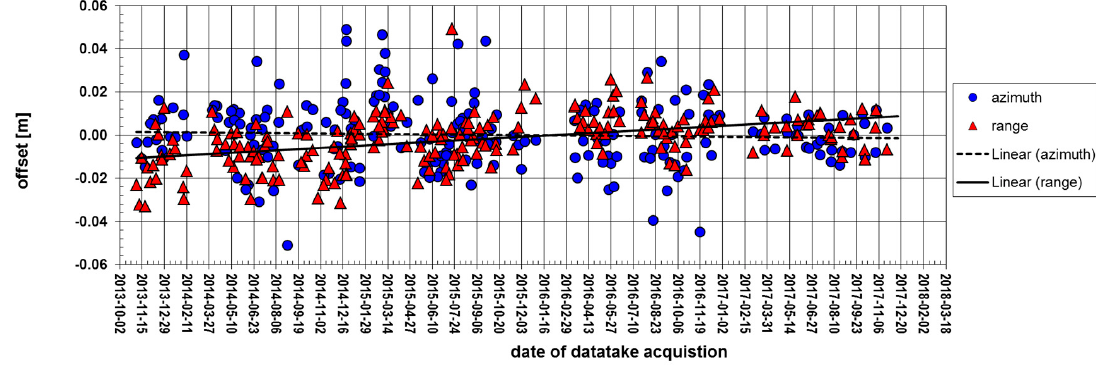
Figure 3. Temporal progression of the azimuth (blue) and range (red) offset obtained at the Metsähovi test site.